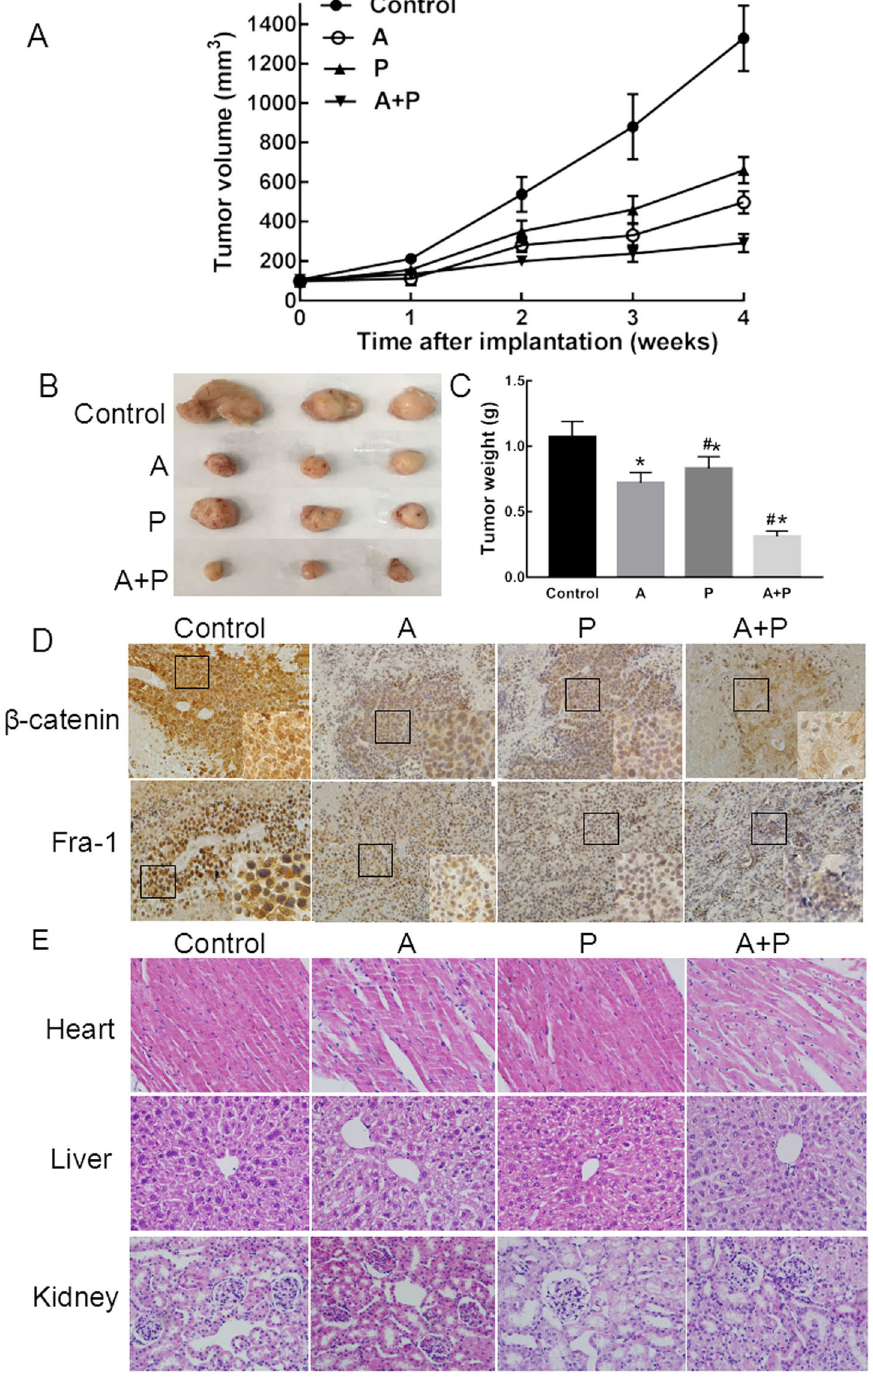
Figure 4. The anti-tumor effect of psoralen in vivo . ( A ) Tumor volume variation, p < 0.05. ( B ) Tumor weights of the mice groups with different treatments, * p < 0.05 vs. control group, # p < 0.05 vs. A group. Each point represents the mean ± SD. ( C ) Representative images of tumors isolated from the xenograft model after 28 days. ( D ) Immunohistochemical analysis for the expression of β -catenin and Fra-1 (magnification, 400x) for mice of all groups. ( E ) Histopathological study of different treated groups; the heart, liver and kidneys were stained by the HE method. The scale bar is 100 μ